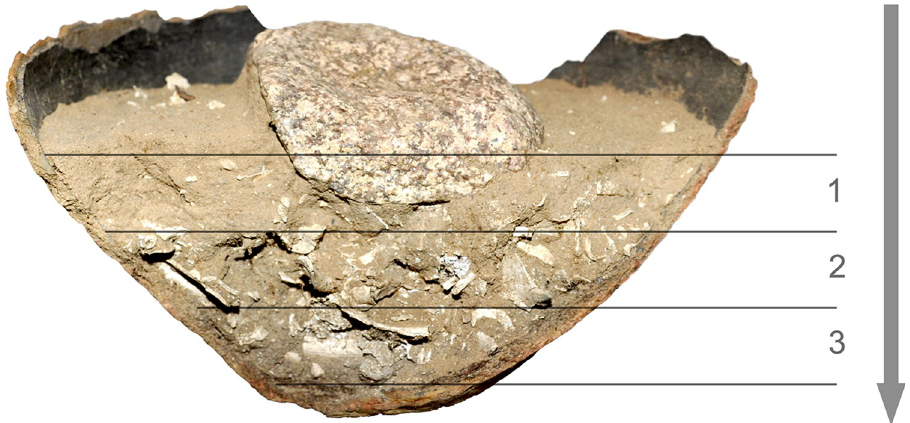
Fig 3. Diagram of the direction of mechanical exploration and the order of nomenclature of individual layers of the urn fills.